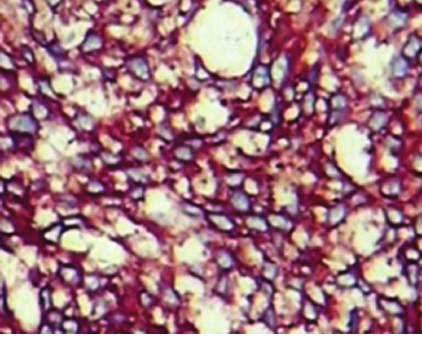
Figure 3: Epithelioid cells strongly positive with CD34 ( ×